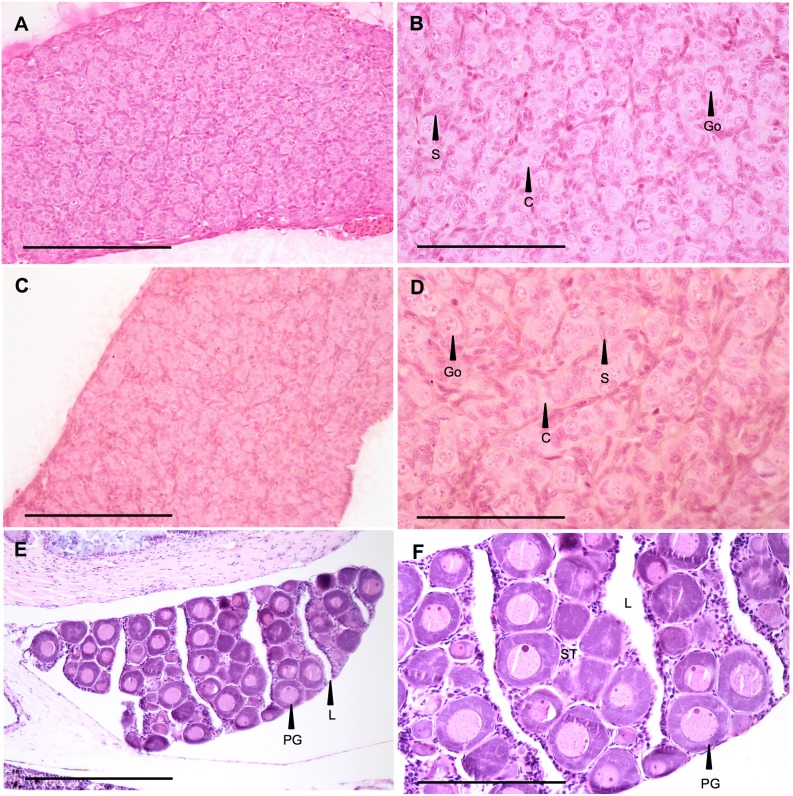
Testicular morphology.A–B: Rainbow trout testis at 136 days post fertilization (dpf), control fish (1360 degree-days). This picture shows the differentiation status of a control testis, with a dominance of gonocytes (Go, future spermatogonia) surrounded by supporting cell (S, future sertoli cell) organized in cords (C, future tubules). HES. Scale bar A = 100 µm, B = 50 µm. C–D: Rainbow trout testis at 136 dpf, fish exposed chronically to 0.01 µg/L of EE2 for 76 days. HES. Go: gonocyte; S: supporting cell. Scale bar C = 100 µm, D = 50 µm. E–F: Normal ovarian morphology. Rainbow trout early stage ovarian morphology, control fish (1350 degree-days). PG: primary growth oocyte; L: lamellae; ST: stroma. Scale bar E = 100 µm, F = 50 µm.